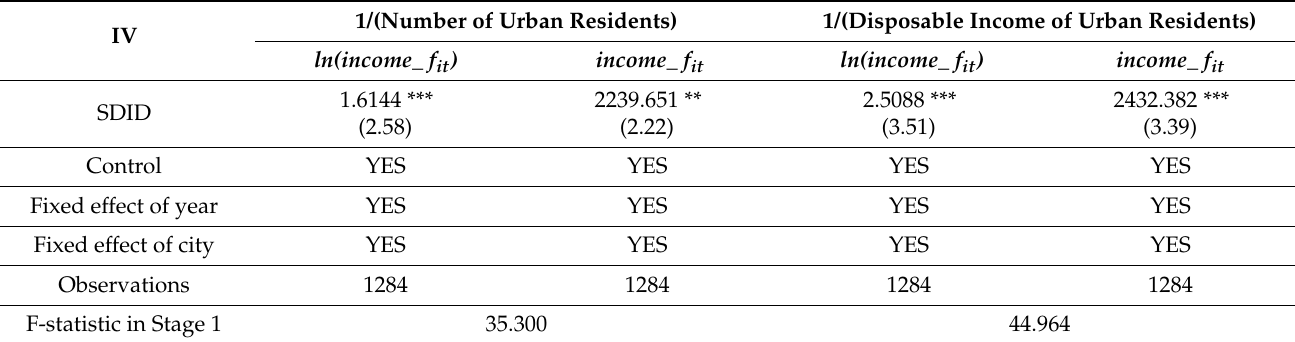
Table 4. Instrumental variables regression